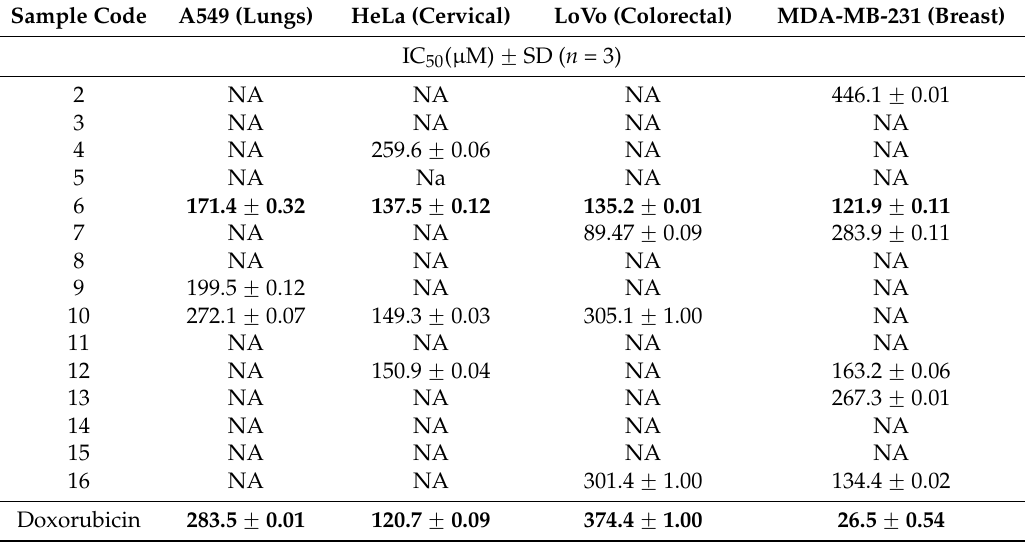
Table 1. In vitro anticancer screening of the synthesized compounds against four cell